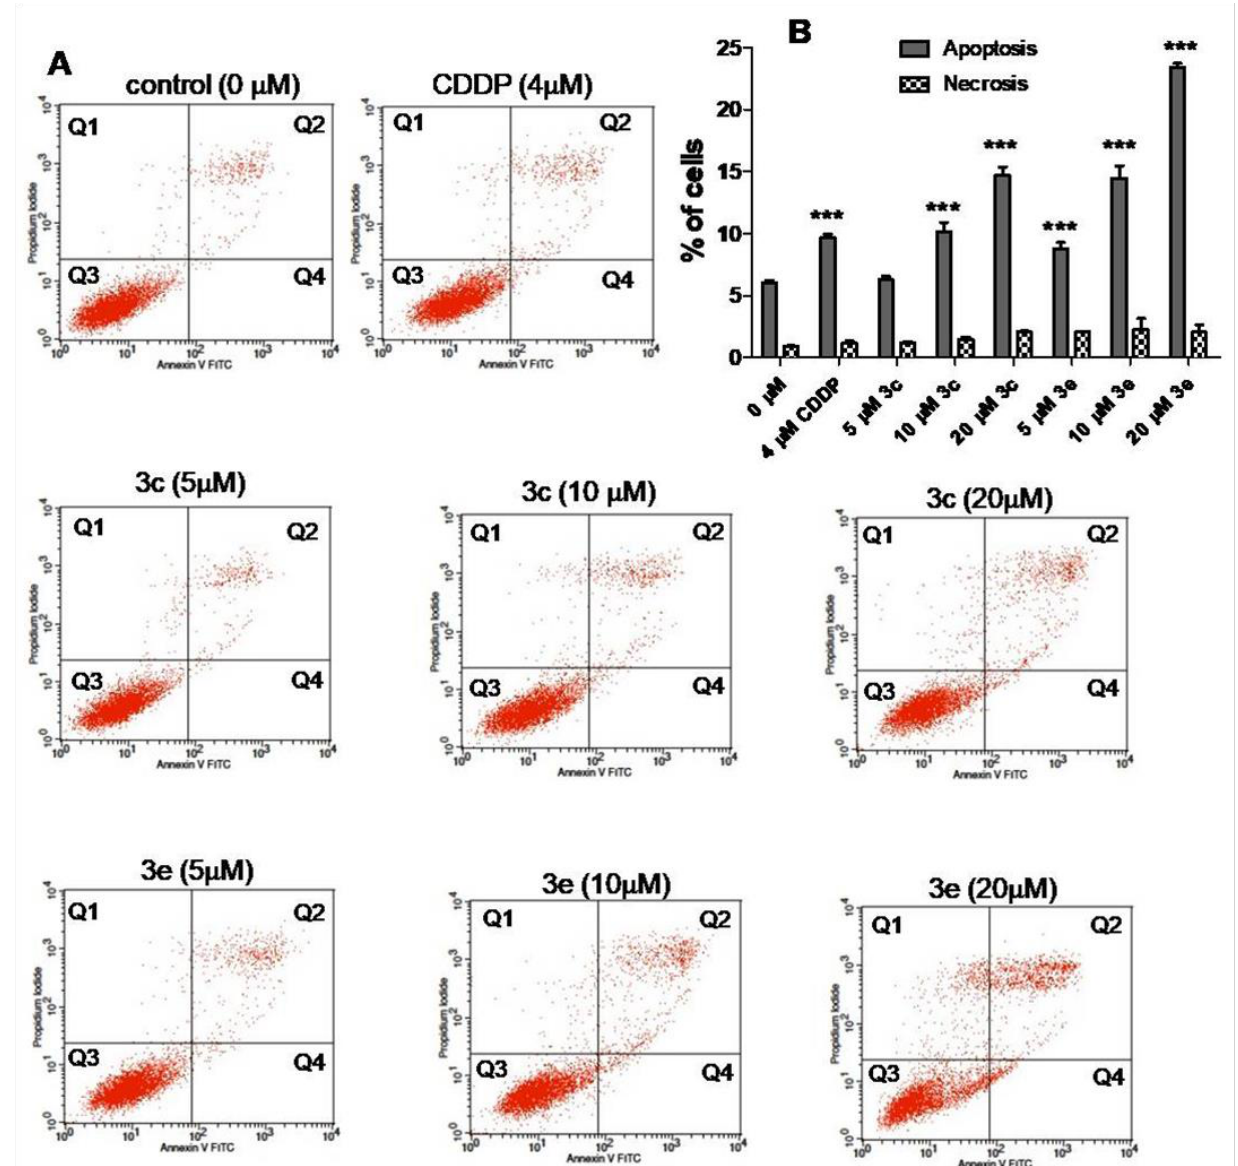
Figure 4. Effect of compounds 3c and 3e and cisplatin (CDDP) on apoptosis induction in the A549 cell line. After the 48-h exposure to the indicated concentrations of the compounds, the cells were stained with annexin (An) V-FITC)/propidium iodide (PI) and examined with flow cytometry. ( A ) The representative graphs obtained by flow cytometric analysis: dot plots indicate the percentage of An − /PI+ necrotic cells (Q1), An+ /PI+ late apoptotic cells (Q2), An − /PI − viable cells (Q3), and An+ /PI − early apoptotic cells (Q4). ( B ) Statistical analysis of the apoptotic (early + late apoptosis) and necrotic rate populations after the 3c , 3e , and cisplatin (CDDP) treatment. Data are presented as mean ± SD from three independent experiments; *** p < 0.001 in comparison to the control; one-way ANOVA followed by Dunnett’s post hoc